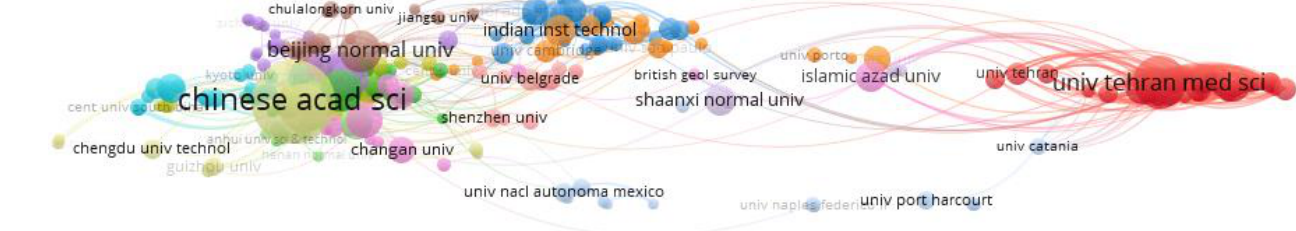
Int. J. Environ. Res. Public Health 2022 , 19 , 5957 Figure 5. Cooperation between institutions. Figure 5. Cooperation between institutions. Figure 5. Cooperation between institutions.